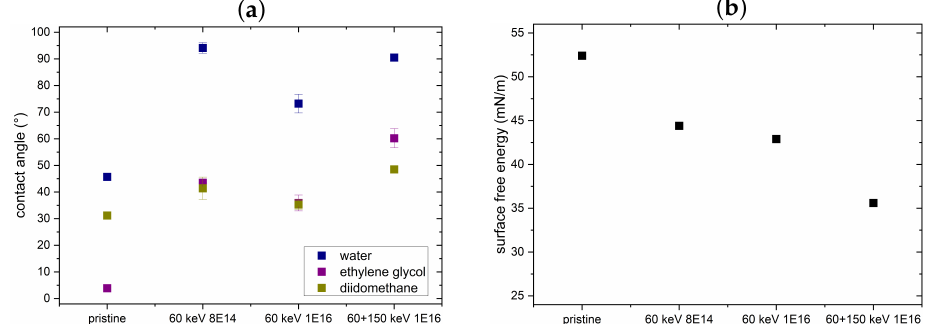
Figure 7. ( a ) Contact angle measurements with water, ethylene glycol and diiodomethane before and after ion bombardment of NT arrays with standard deviation. ( b ) SFEs calculated according to Owens–Wendt–Rabel–Kaelble from the respective contact angles.